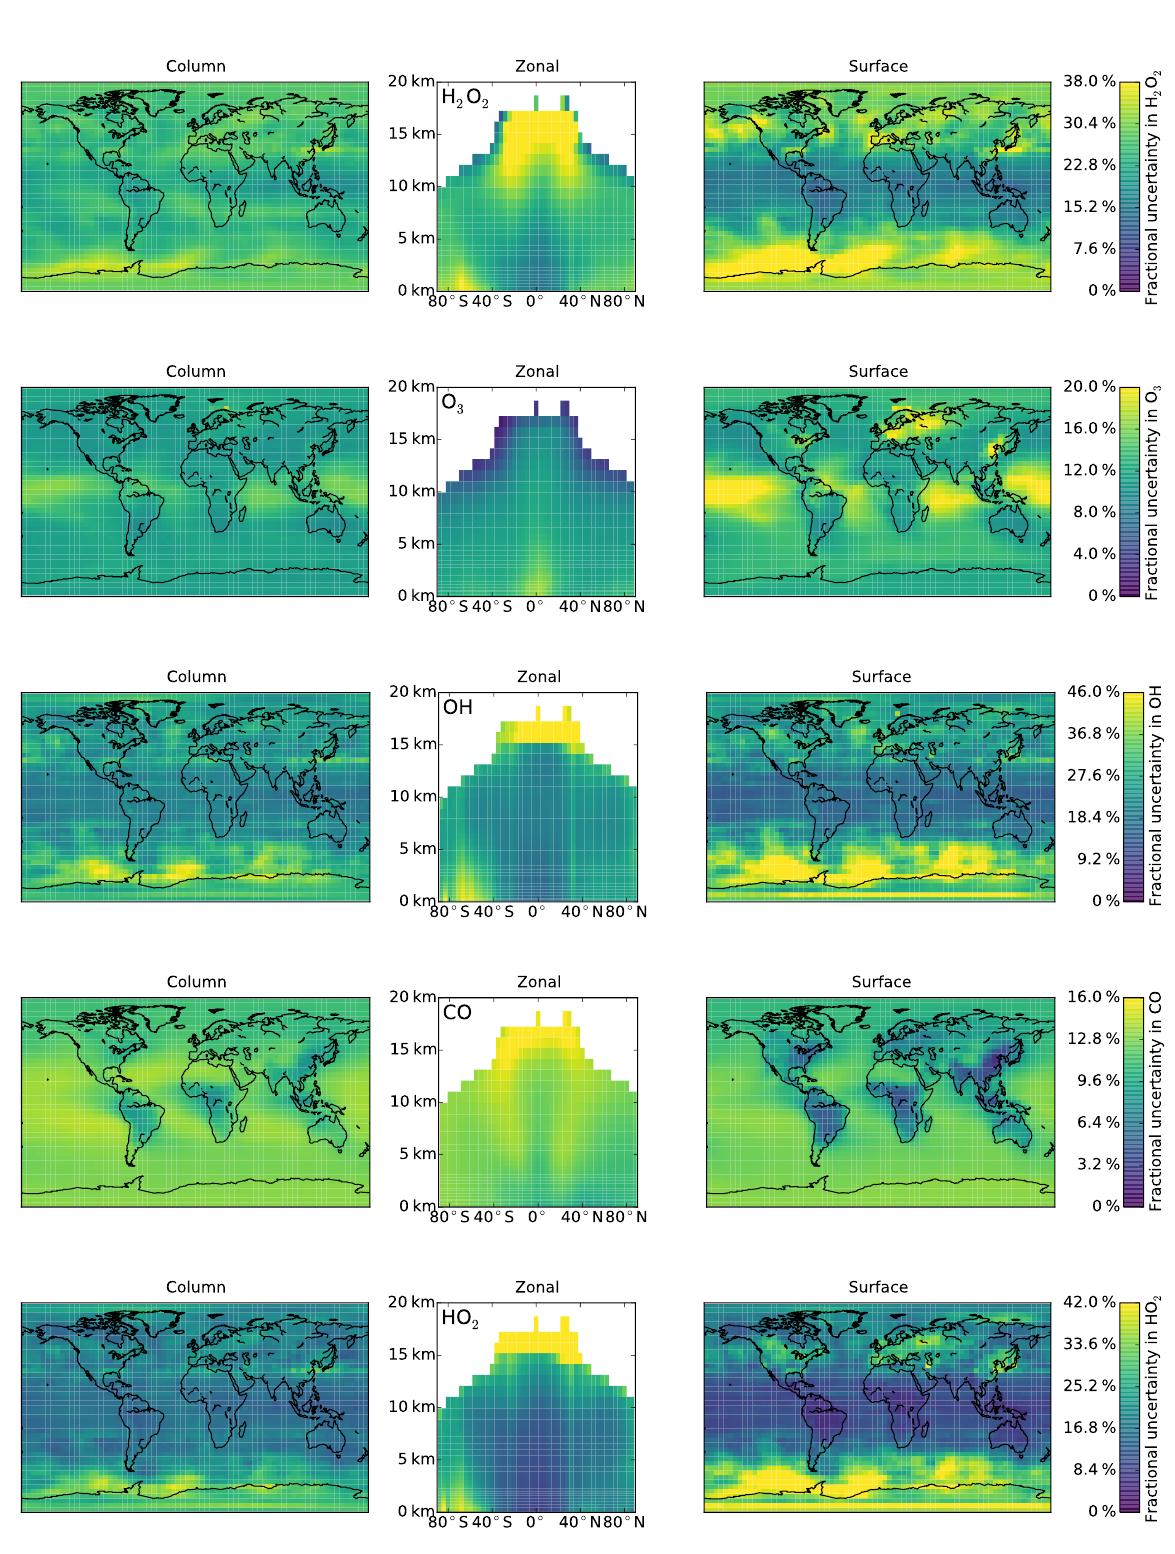
Figure 11. Inorganics: total 1 σ uncertainty in the concentrations of H 2 O 2 , O 3 , OH, CO and HO 2 from the addition in quadrature of the individual reaction uncertainties. “Column” covers the tropospheric